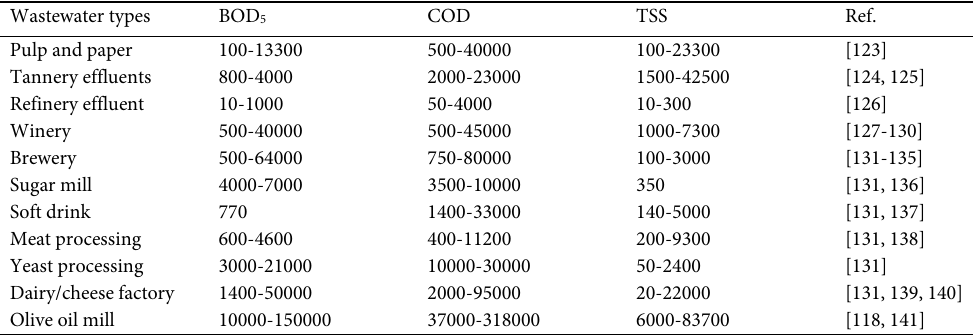
Table1. Amount of pollutants in various industrial wastewaters Table 1. Amount of pollutants in various industrial